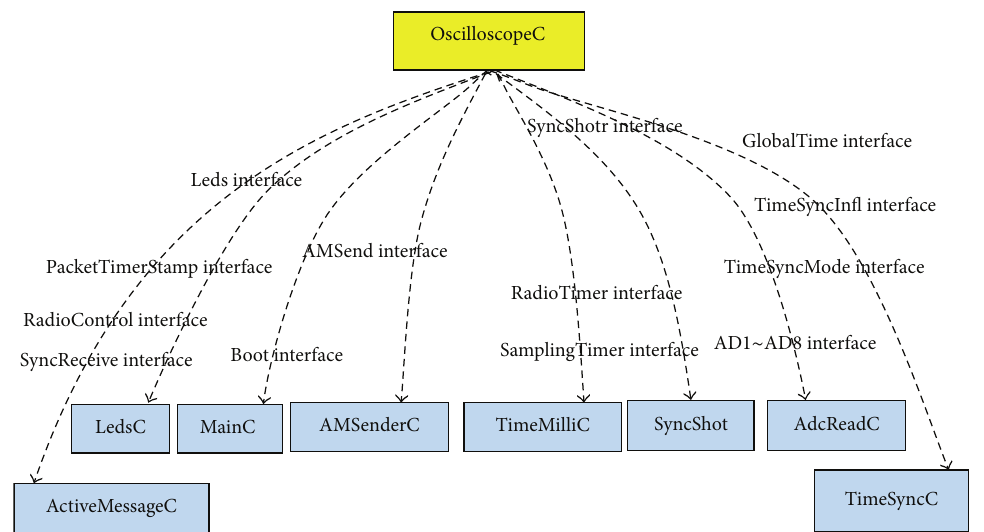
Figure 3: The application components for wireless strain